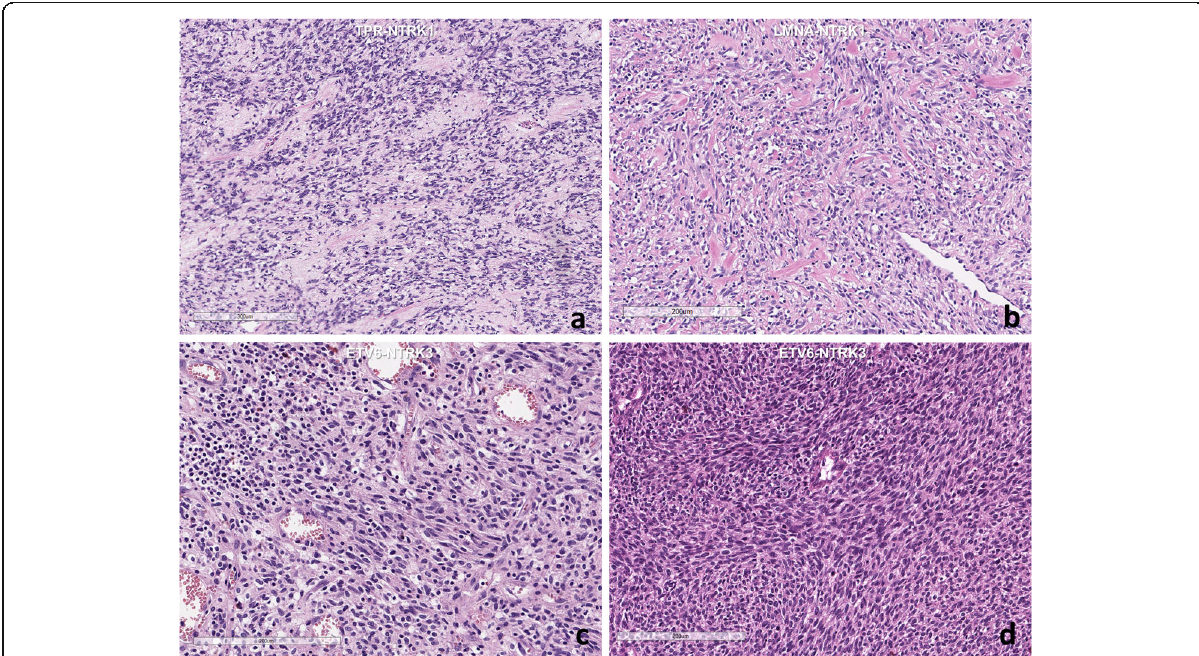
Fig. 3 a Histology of the intracranial undifferentiated sarcoma with TPR-NTRK1 fusion shows alternating cellular areas with collagen bands show a tiger pattern-like appearance. The tumor cells are oval to short spindle cells. b The forehead mesenchymal tumor with LMNA-NTRK1 fusion shows relatively low cellular spindle cell mesenchymal tumor with keloid type collagen laydown. c The pulmonary inflammatory myofibroblastic tumor with ETV6-NTRK3 fusion shows bland-looking spindle cells with intermixed lymphoplasma cells. d A sacrococcygeal infantile fibrosarcoma with ETV6-NTRK3 fusion shows fascicular spindle cells with high cellularity ( a-d : H&E, bar: a : 300, μ m, b-d : 50 μ